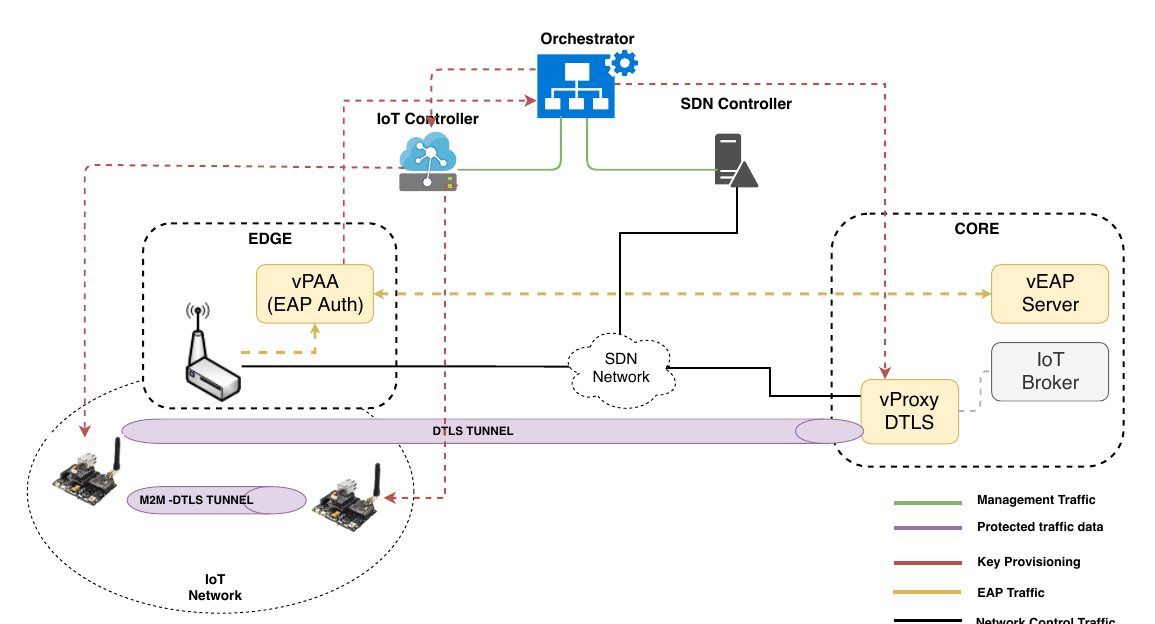
Figure 2. vAAA and vChannel-Protection deployment in the IoT